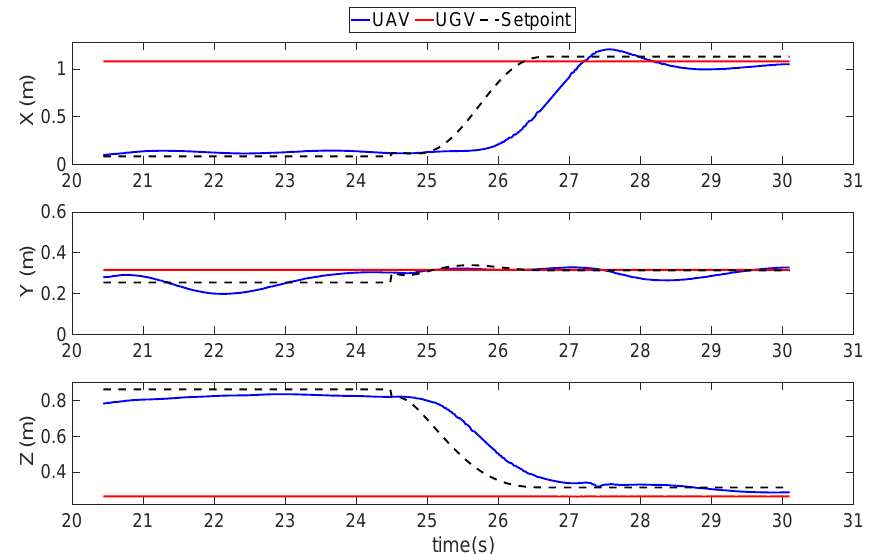
Figure 12. Position results of a quadrotor UAV conducting the proposed ground-effect free landing trajectory.